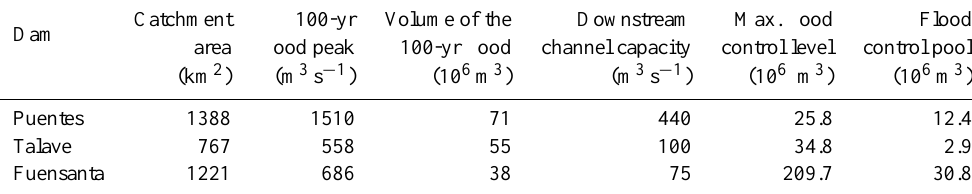
Table 1. Case studies: Characteristics of the reservoirs and respective catchments.